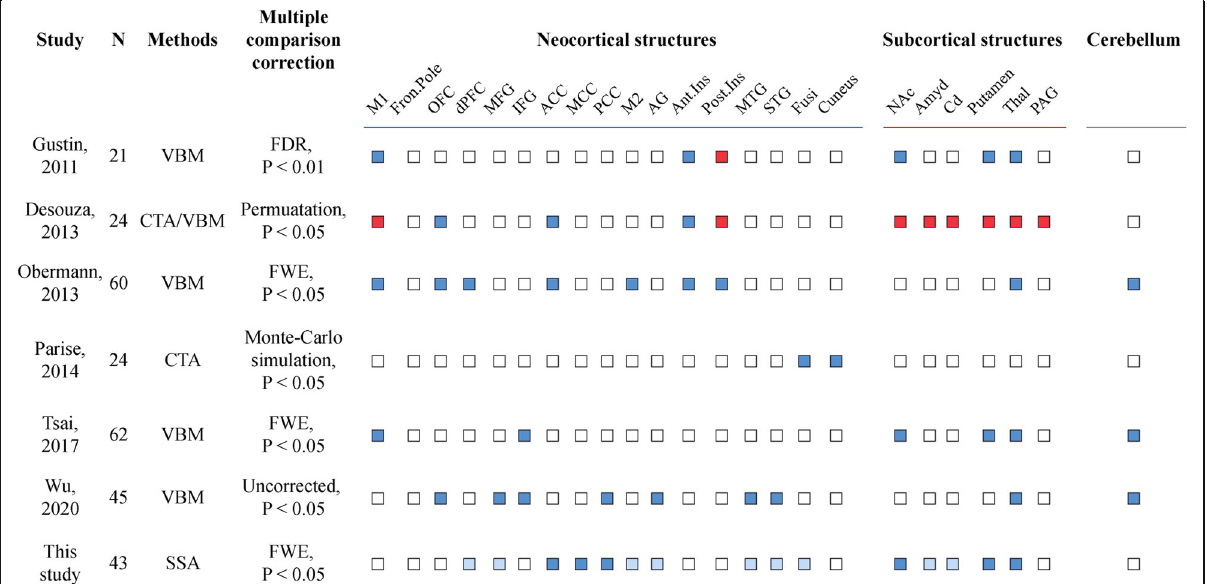
Fig. 4 Systematic review of whole-brain studies assessing TN-related neuroimaging patterns. Sample size and quantitative MRI approaches are indicated along with reported findings (Red: increased cortical thickness or volume; Blue: decreased cortical thickness or volume, light blue: significant outcomes without correction; white: no assessment) across 3 brain subsystems (neocortical, subcortical structures and brainstem). VBM: voxel-based morphometry; CTA: cortical thickness analysis; SSA: surface-based shape analysis; FDR: false discovery rate; FWE: family-wise error; M1: primary somatosensory cortex; Fron. pole: frontal pole; OFC: orbitofrontal cortex; dPFC: dorsolateral prefrontal cortex; MFG: middle frontal gyrus; IFG: inferior frontal gyrus; ACC: anterior cingulate cortex; MCC: midcingulate cortex; PCC: posterior cingulate cortex; AG: angular gyrus; Ant.Ins: anterior insula; Post.Ins: posterior insula; Fusi: fusiform gyrus; Nac: nucleus accumbens; Amyg: amygdala; Cd: caudate nucleus; Thal: thalamus; PAG: periaqueductal